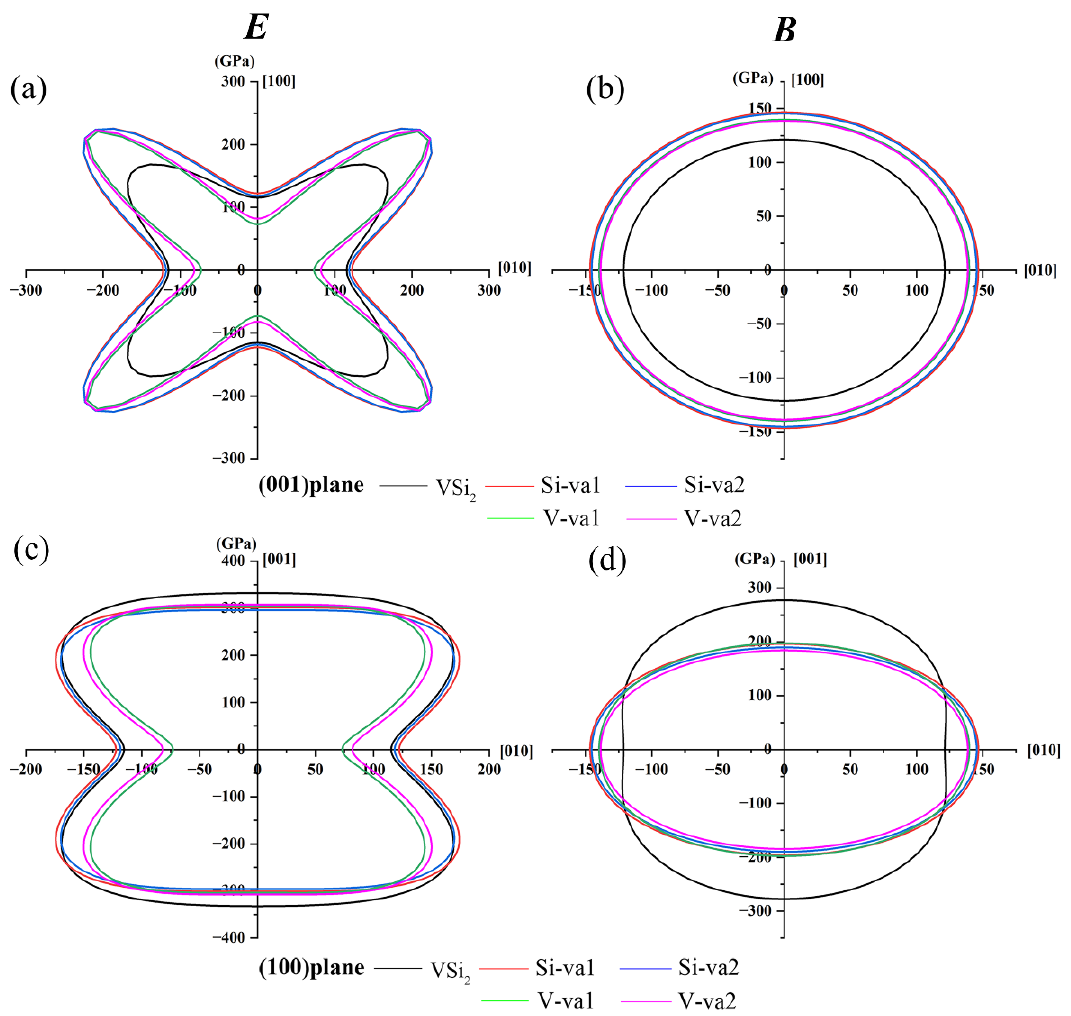
Figure 5. Two-dimensional projections of bulk and Young’s moduli on the (001) and (100) planes of C11 b -VSi 2 . ( a ) Young’s moduli on the (001) plane; ( b ) Bulk moduli on the (001) plane; ( c ) Young’s moduli on the (100) plane; ( d ) Bulk moduli on the (100) plane.